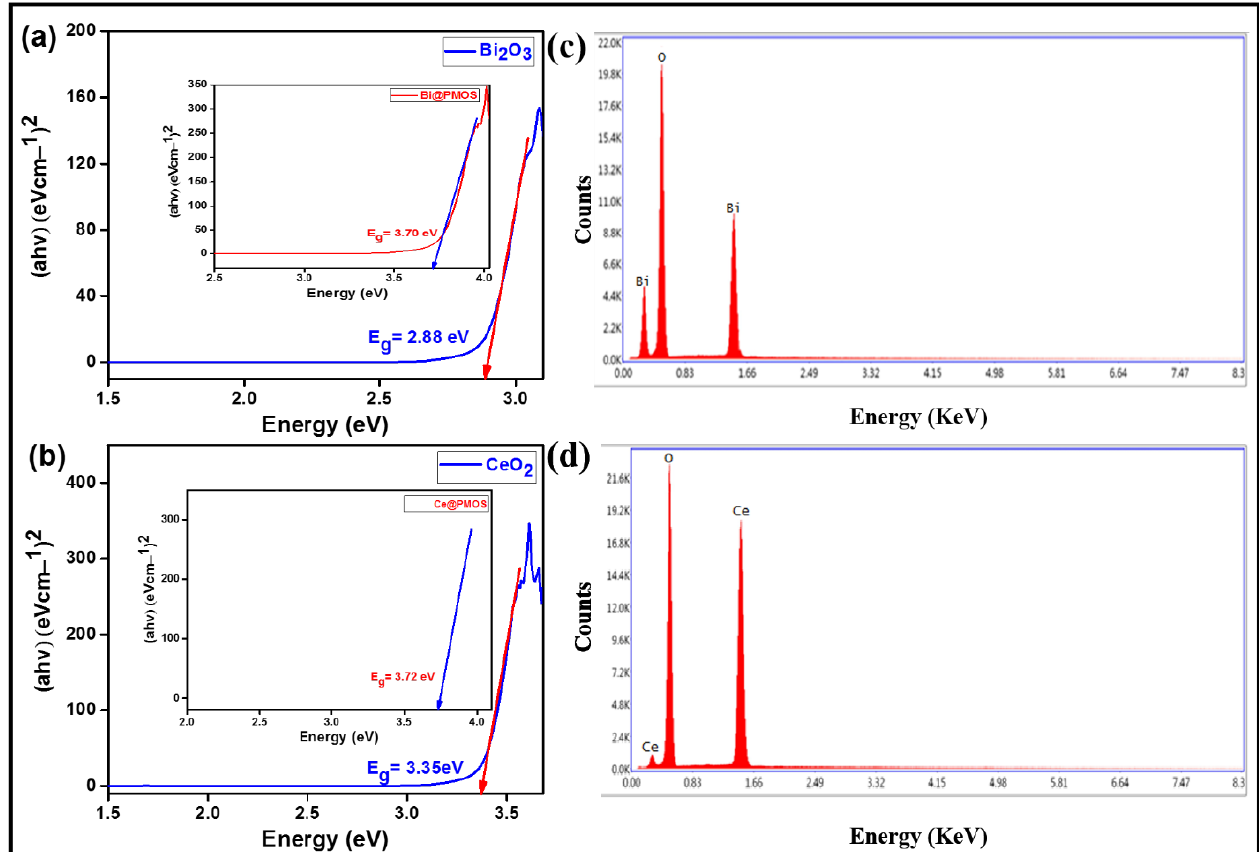
Figure 3. ( a , b ) Band gap of Bi 2 O 3 and CeO 2 and ( c , d ) EDX images of Bi 2 O 3 and CeO 2.